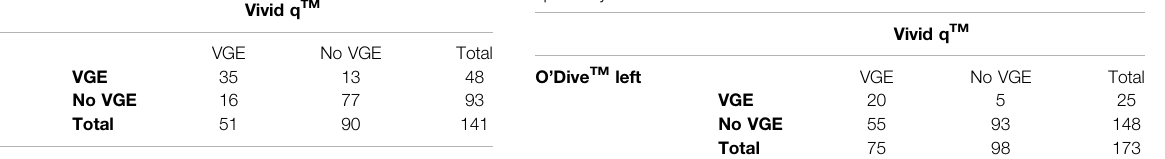
TABLE 5 | Contingency table showing venous gas emboli (VGE) presence agreement between the Vivid q TM and the O ’ Dive ™ left measurement. The O ’ Dive ™ left measurement sensitivity was found to be 26.7% and its speci fi city 94.9%.